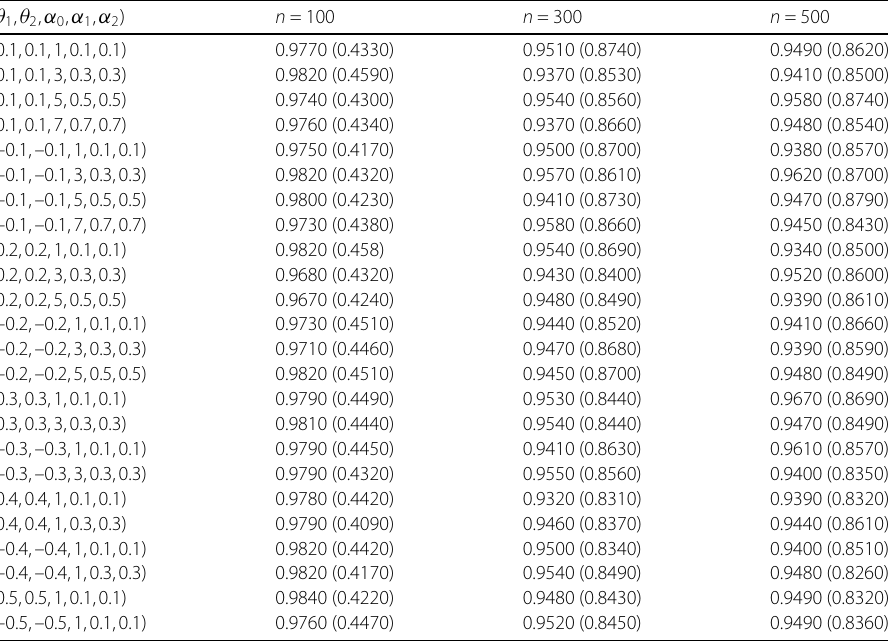
Table 2 The simulation results for sequence II ( (cid:9) , σ 1 , σ 2 ) = (0.9,1,3) ( θ 1 , θ 2 , α 0 , α 1 , α 2 ) n = 100 n = 300 n = 500